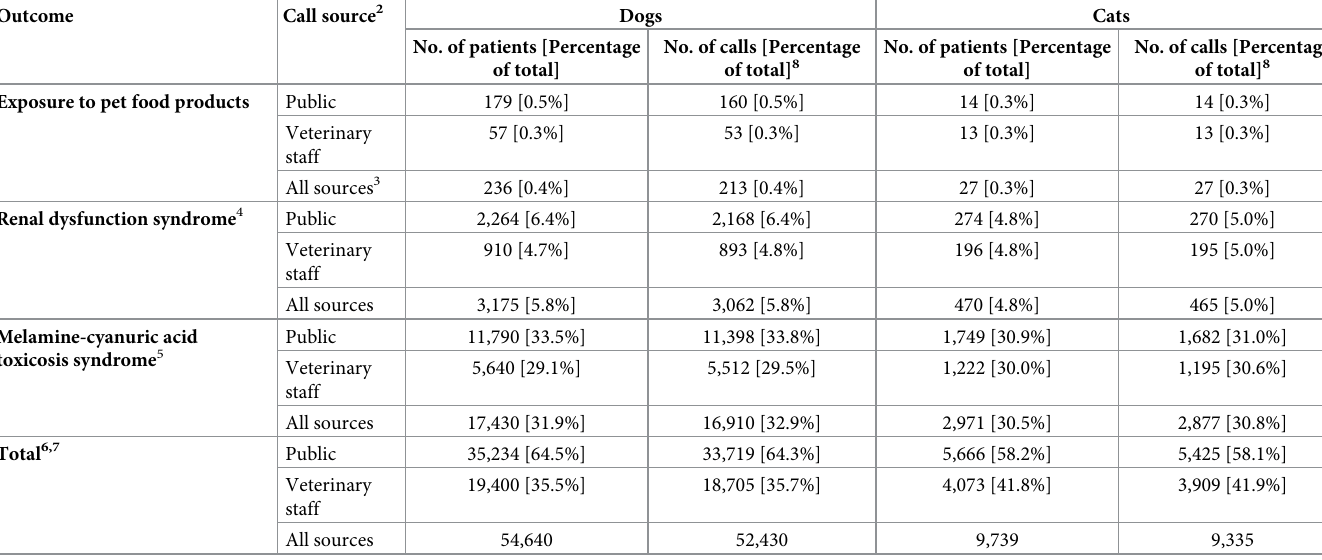
Table 2. Summary of the number and percent of dogs and cats involved in suspected exposures to potentially toxic substances reported to the APCC 1 from 2005 to 2007, by surveillance outcome and call source.